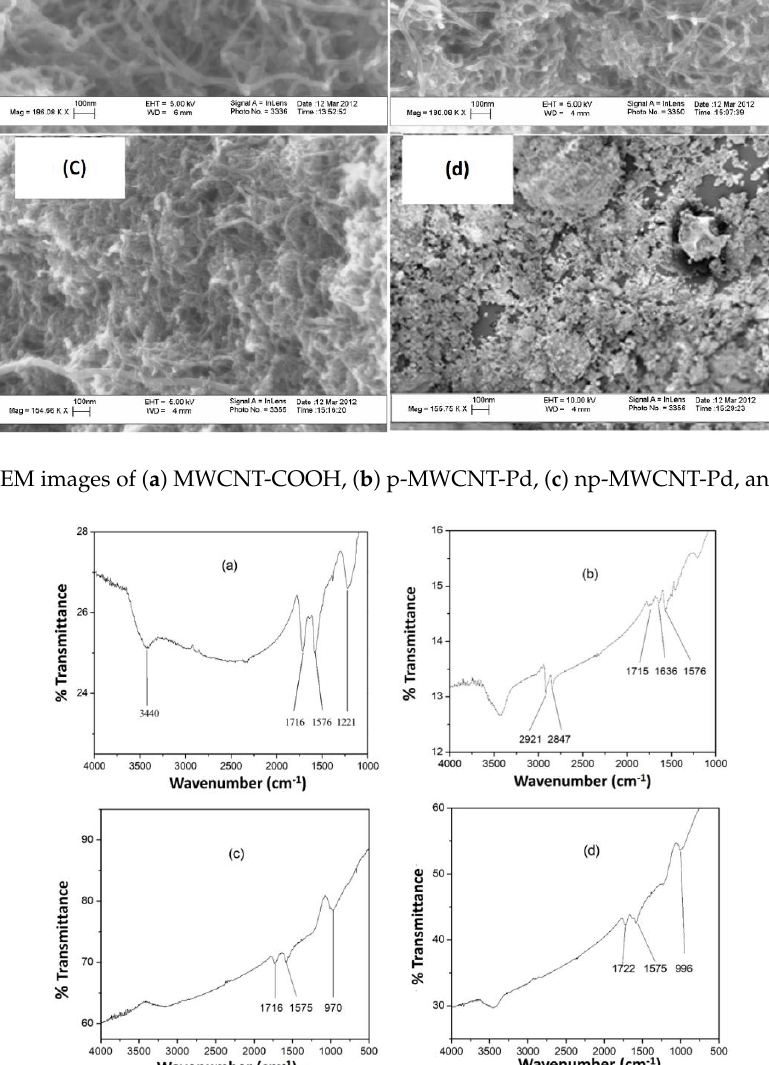
Figure 2. FTIR data for ( a ) MWCNT-COOH, ( b ) MWCNT-ODA, ( c ) p-MWCNT-Pd, and ( d ) np- MWCNT-Pd.